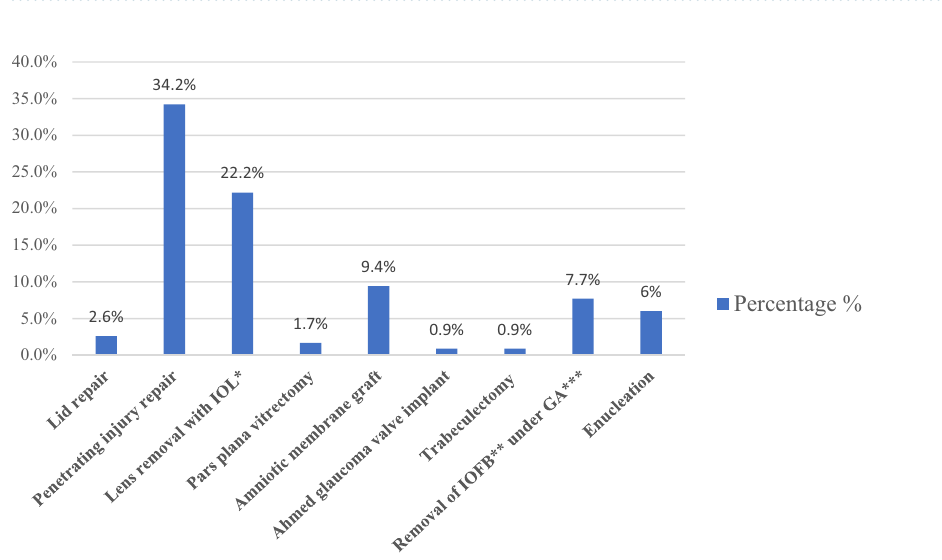
Figure 2. Ocular surgeries performed on the eyes of Saudi children with fireworks-related injuries. Abbreviations: * IOL Intraocular lens, ** IOFB Intraocular foreign bodies, *** GA General